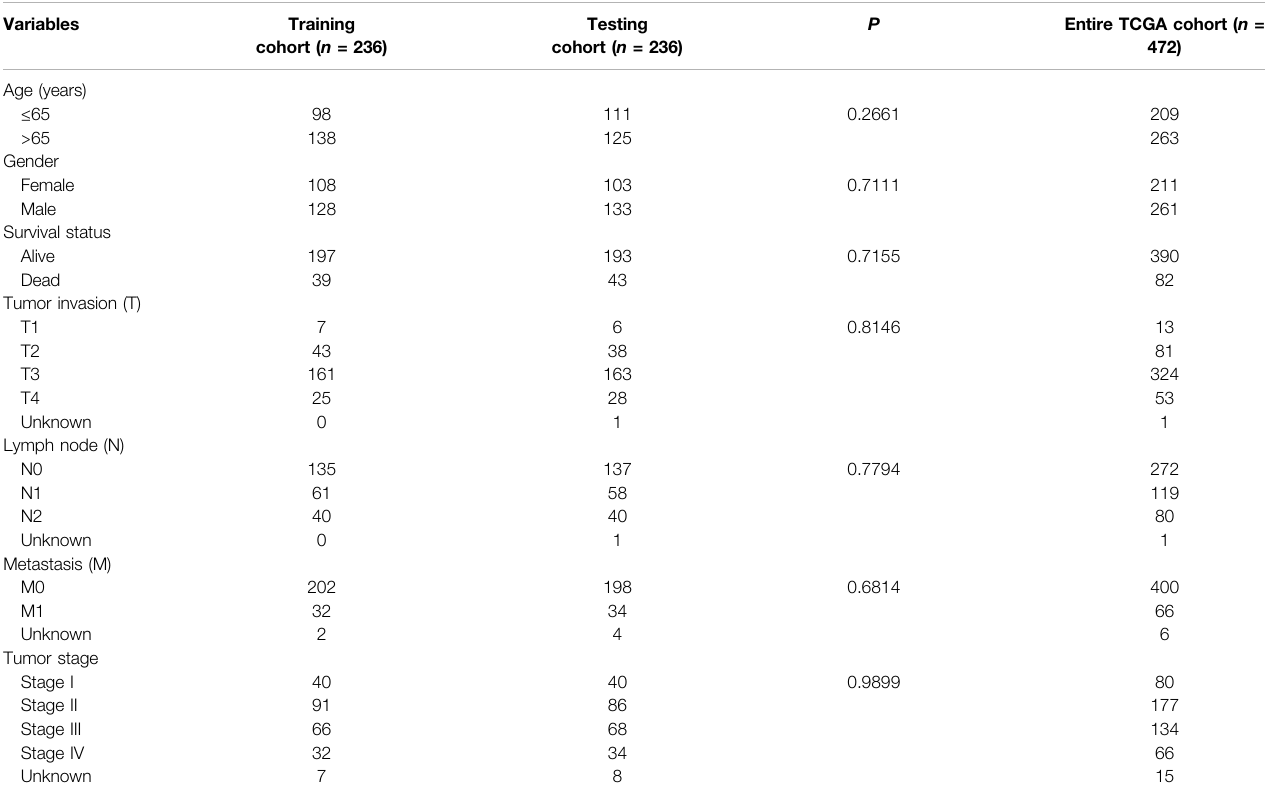
TABLE 1 | Clinical features of the patients with CRC in each